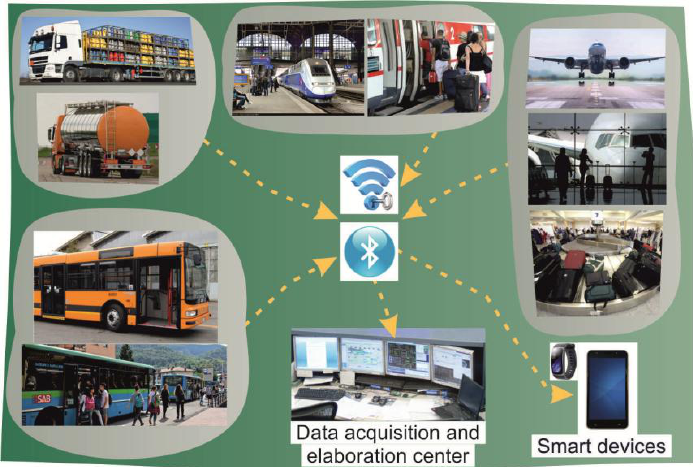
Figure 3. CCS applications coupling the cyber and object domain for the security of public transit and transport services. Trucks, buses, trains and train stations, airports, planes, luggage stores and luggage check instruments are all equipped with the chemical sensors.